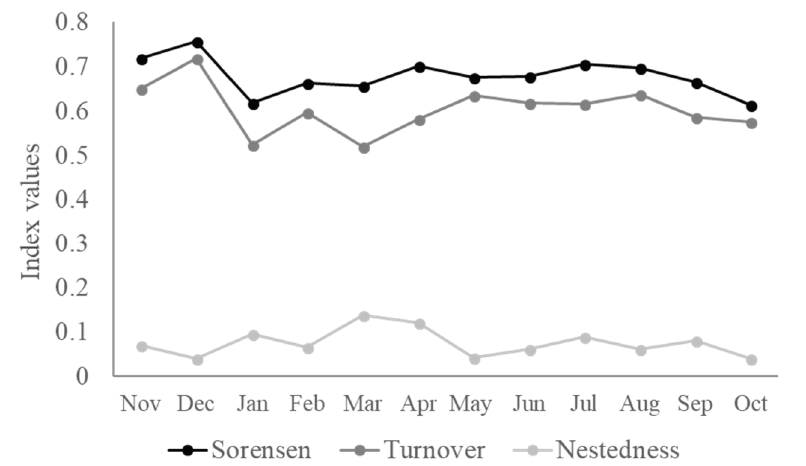
Figure 3. Phytoplankton beta diversity according to Sorensen similarity index (bSOR), turnover (bSIM) and nestedness (bNES) components values in Lafra, Lafrouda, Lagos, Palaia Koiti and Vistonis lagoons during the period from November 2018 to October 2019.